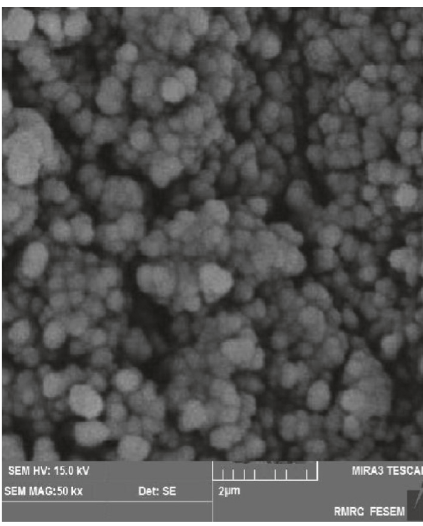
Figure 1: Silica nanoparticles with an average particle size of